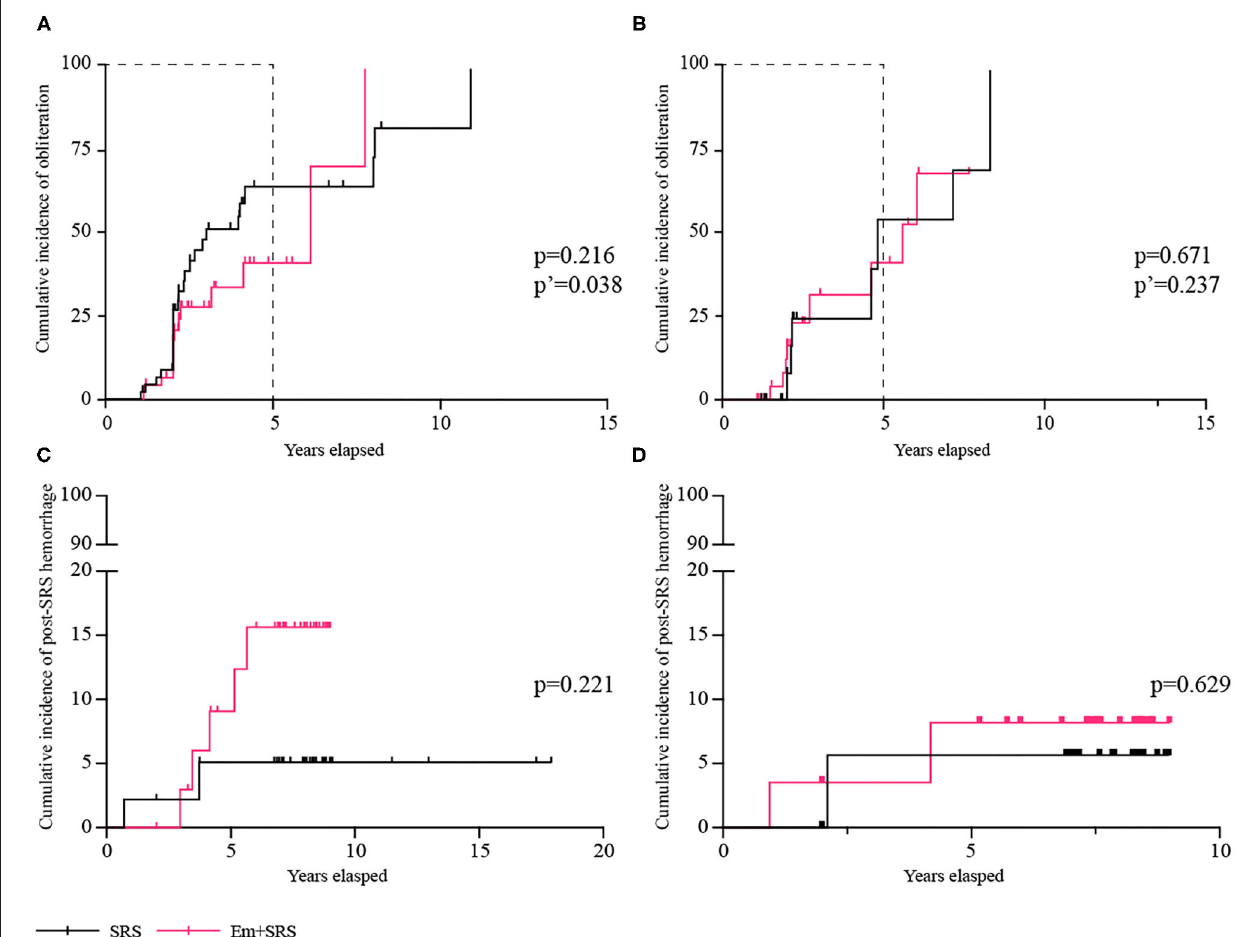
FIGURE 3 | Comparisons of cumulative incidence in ruptured subgroup between SRS and Em + SRS. (A) AVM obliteration. (C) Post-SRS hemorrhage. Comparisons of cumulative incidence in the unruptured subgroup between SRS and Em + SRS: (B) AVM obliteration. (D) Post-SRS hemorrhage. AVM, arteriovenous malformation; Em + SRS, embolization + stereotactic radiosurgery. p ′ -Value refers to the result of a 5-year follow-up.